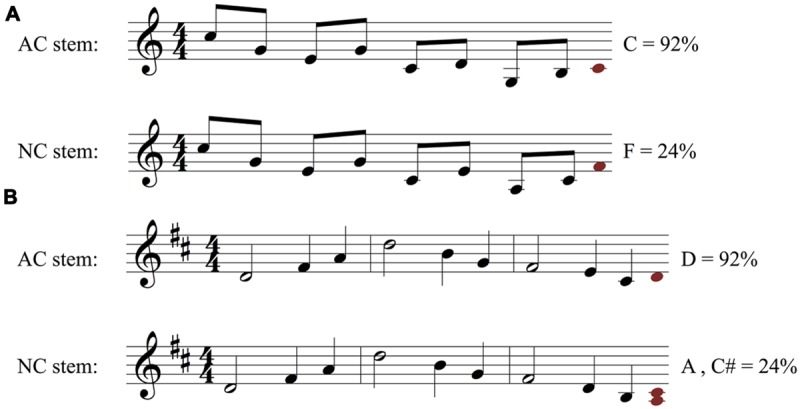
Examples of two melodic stem pairs (A,B) with an AC stem that was much more constraining than the non-cadence (NC) stem. Stems are shown in black and white, and for each stem the most frequently sung note is shown as a red note head at the end of the stem. The pitch class name of this note and the proportion of listeners who sang the note (i.e., the measured melodic constraint of the stem) are printed next to the red note. These two pairs correspond to stem pairs 4 and 3 in Figure 3 [the stems in panel (B) are the same as in Figure 1].